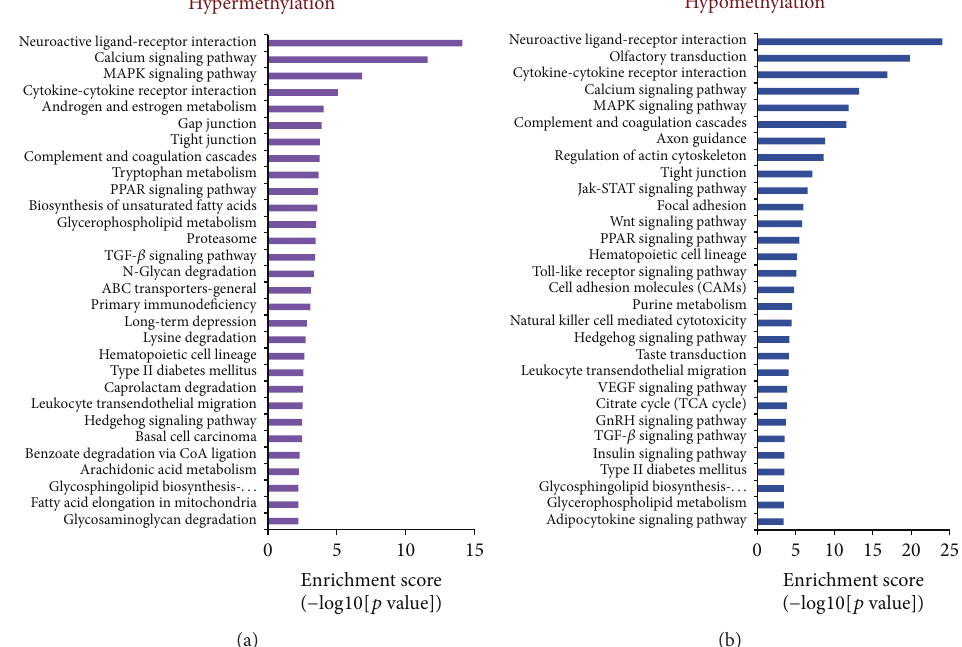
Figure 6: The pathways of DNA methylation changes in F1 offspring exposed to intrauterine hyperglycemia. Immunoprecipitated DNA was amplified and hybridized on Rat DNA Methylation 3 × 720 K CpG Island Plus RefSeq Promoter Array according to the Roche NimbleGen protocol. Microarray data was extracted and analyzed by the Molecular Annotation System (CB-MAS, CapitalBio Corporation, Beijing, China,